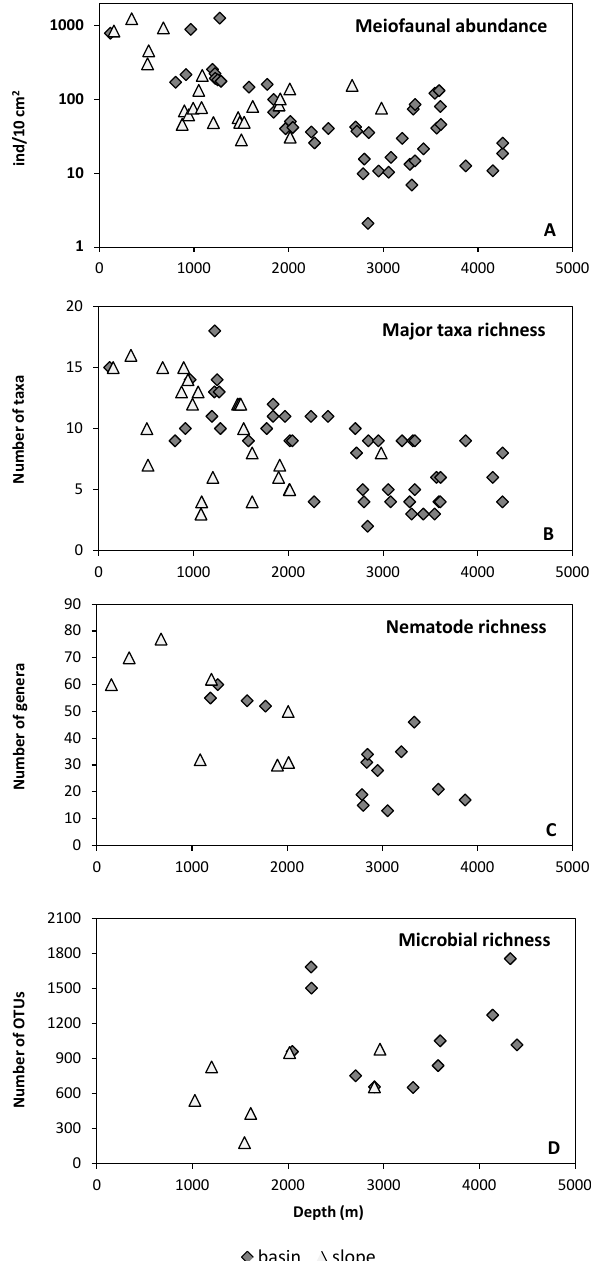
Fig. 7. Bathymetric gradient of (A) meiofaunal abundance ( n = 69), (B) major taxa richness ( n = 69), (C) nematode genus richness ( n = 22) and (D) microbial richness ( n = 19). Note the logarithmic scale for meiofaunal abundance.